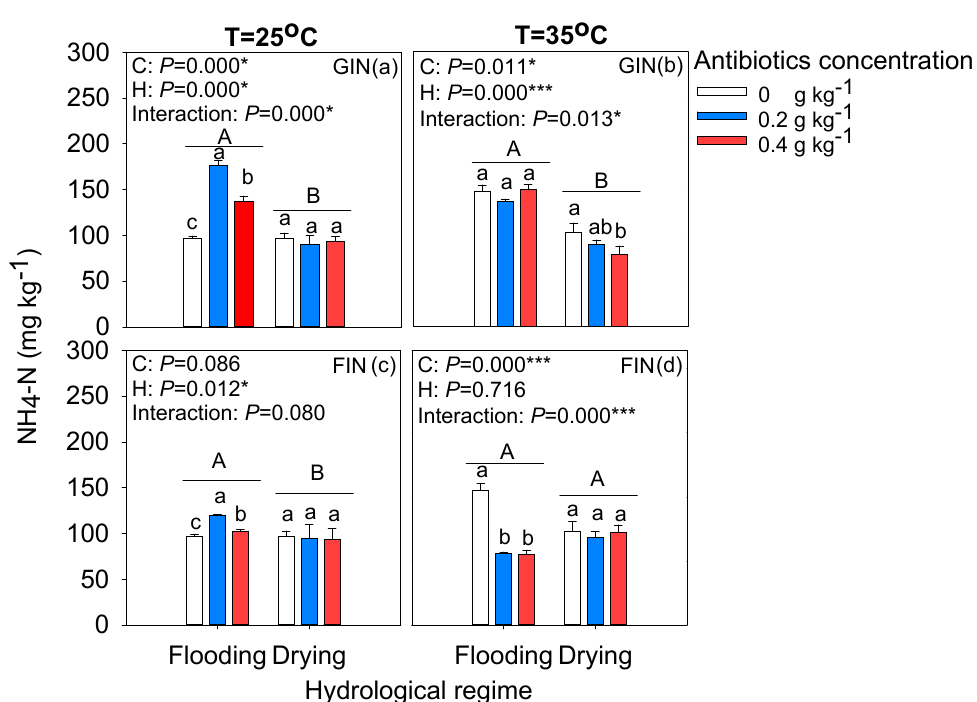
Figure 1. The variation of ammonium at 25 °C and 35 °C during 30 − day flooding or drying incubation. Different uppercase letters indicate significant differences between flooding and drying. Different lowercase letters represent significant differences among antibiotics concentration under flooding or drying conditions. Different numbers of asterisks represent a significant difference (* p < 0.05, ** p < 0.01, *** p < 0.001).